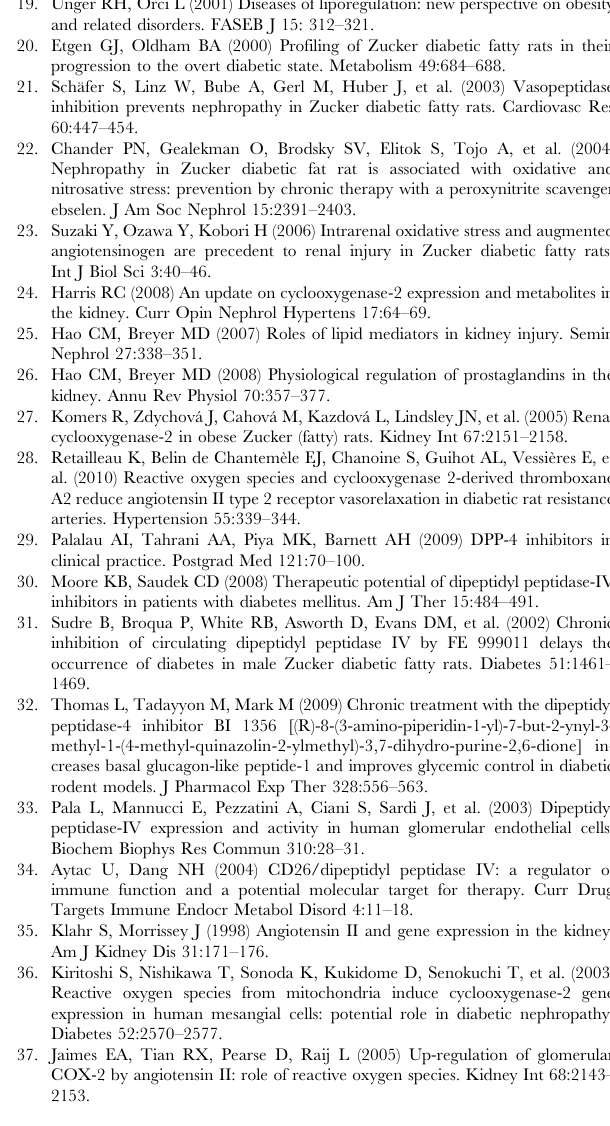
Figure S1 Acute effects of oral NWT-03 and VIL on plasma DPP4 activity and blood pressure in ZDF rats.